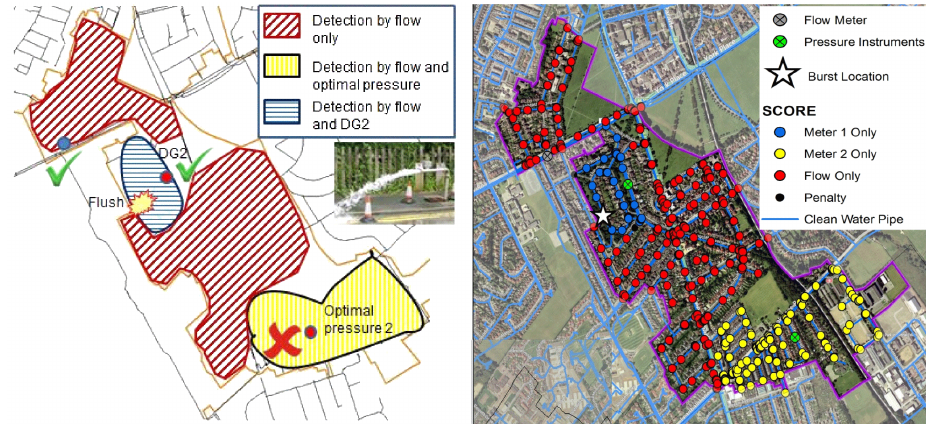
Figure 4. Sub-DMA location of blind event in the pilot area (after Farley et al., 2012).